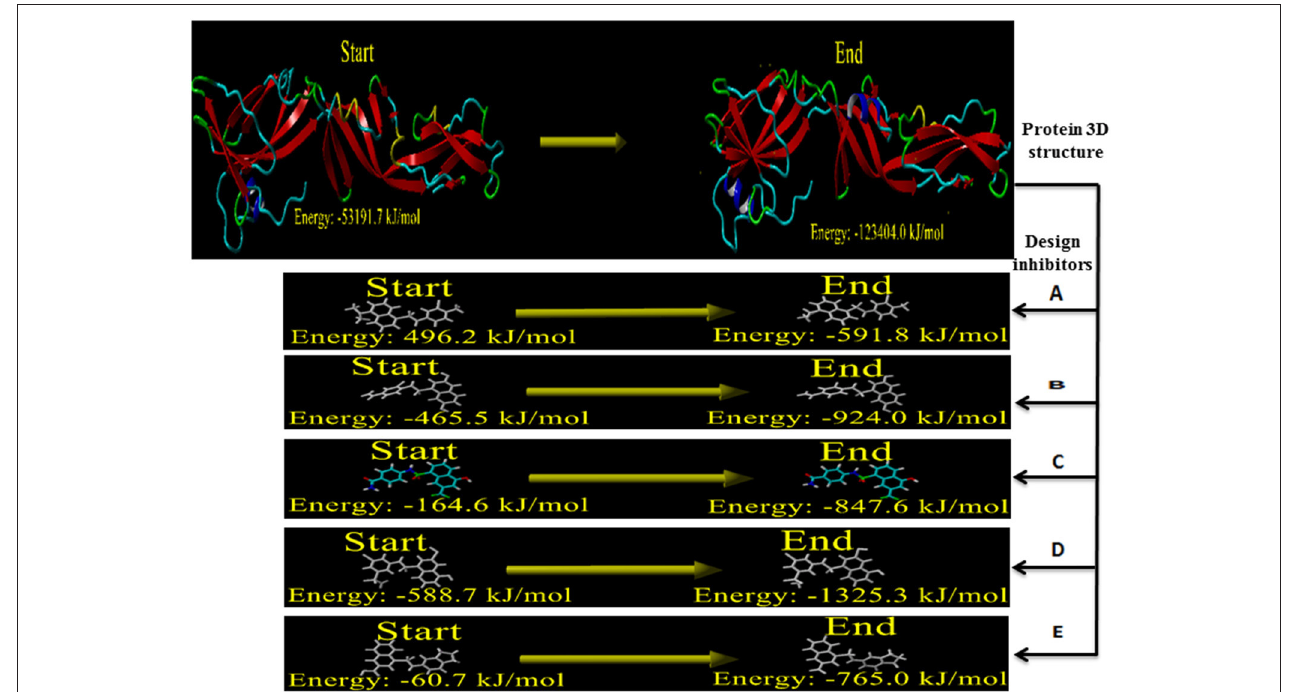
FIGURE 8 | Energy minimization of built model of envelope glycoprotein and designed inhibitors.